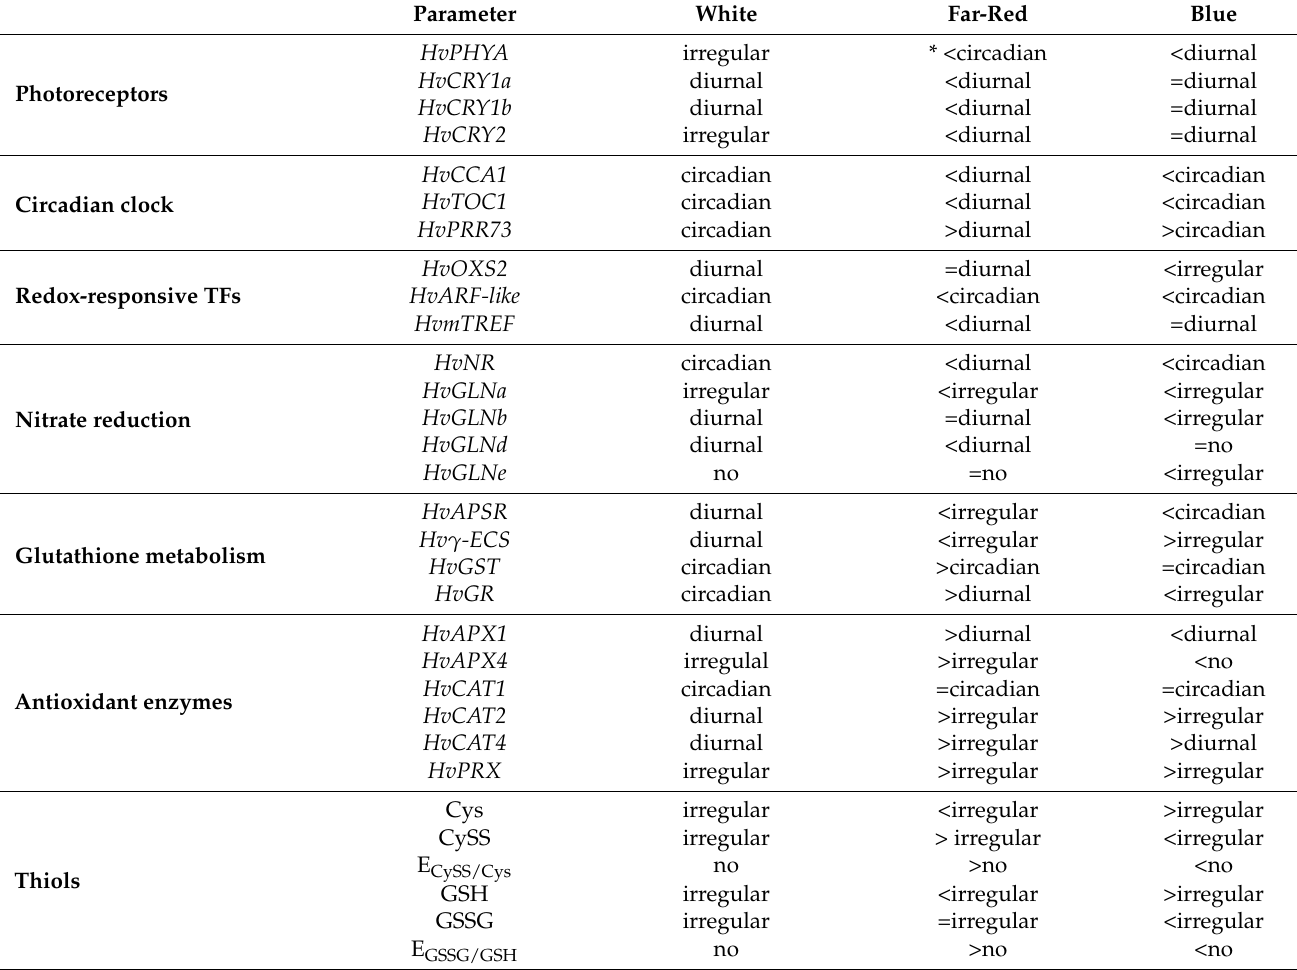
Table 1. Type of oscillations in transcript and thiol levels and half-cell reduction potentials under various spectral